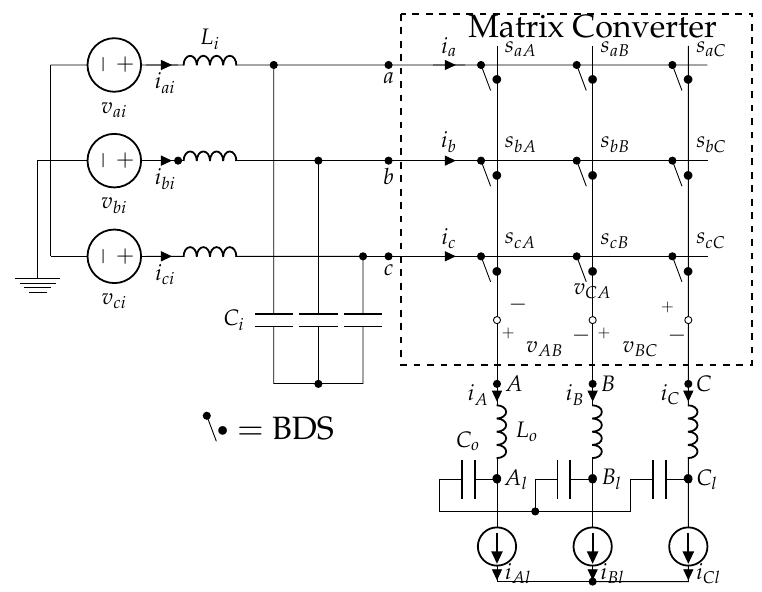
Figure 1. Matrix converter circuit and peripherals. BDS, Bi-Directional power Switches.